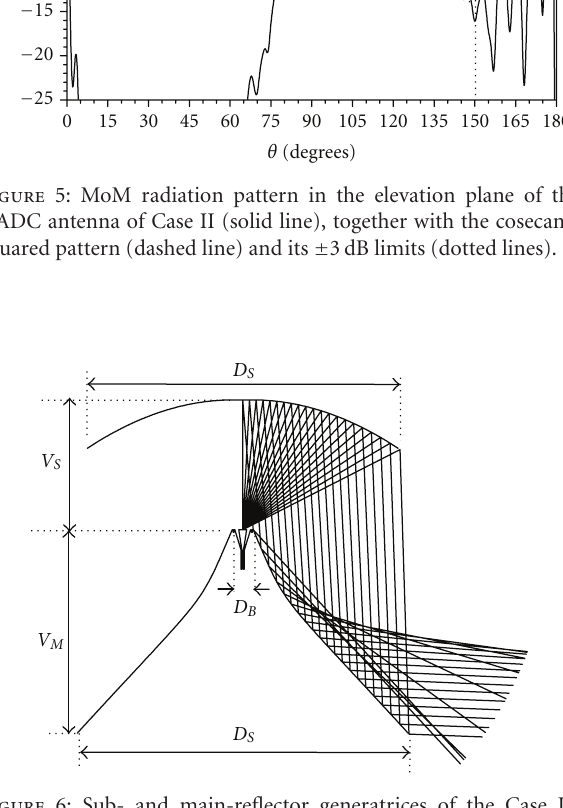
Figure 6: Sub- and main-reflector generatrices of the Case III OADC